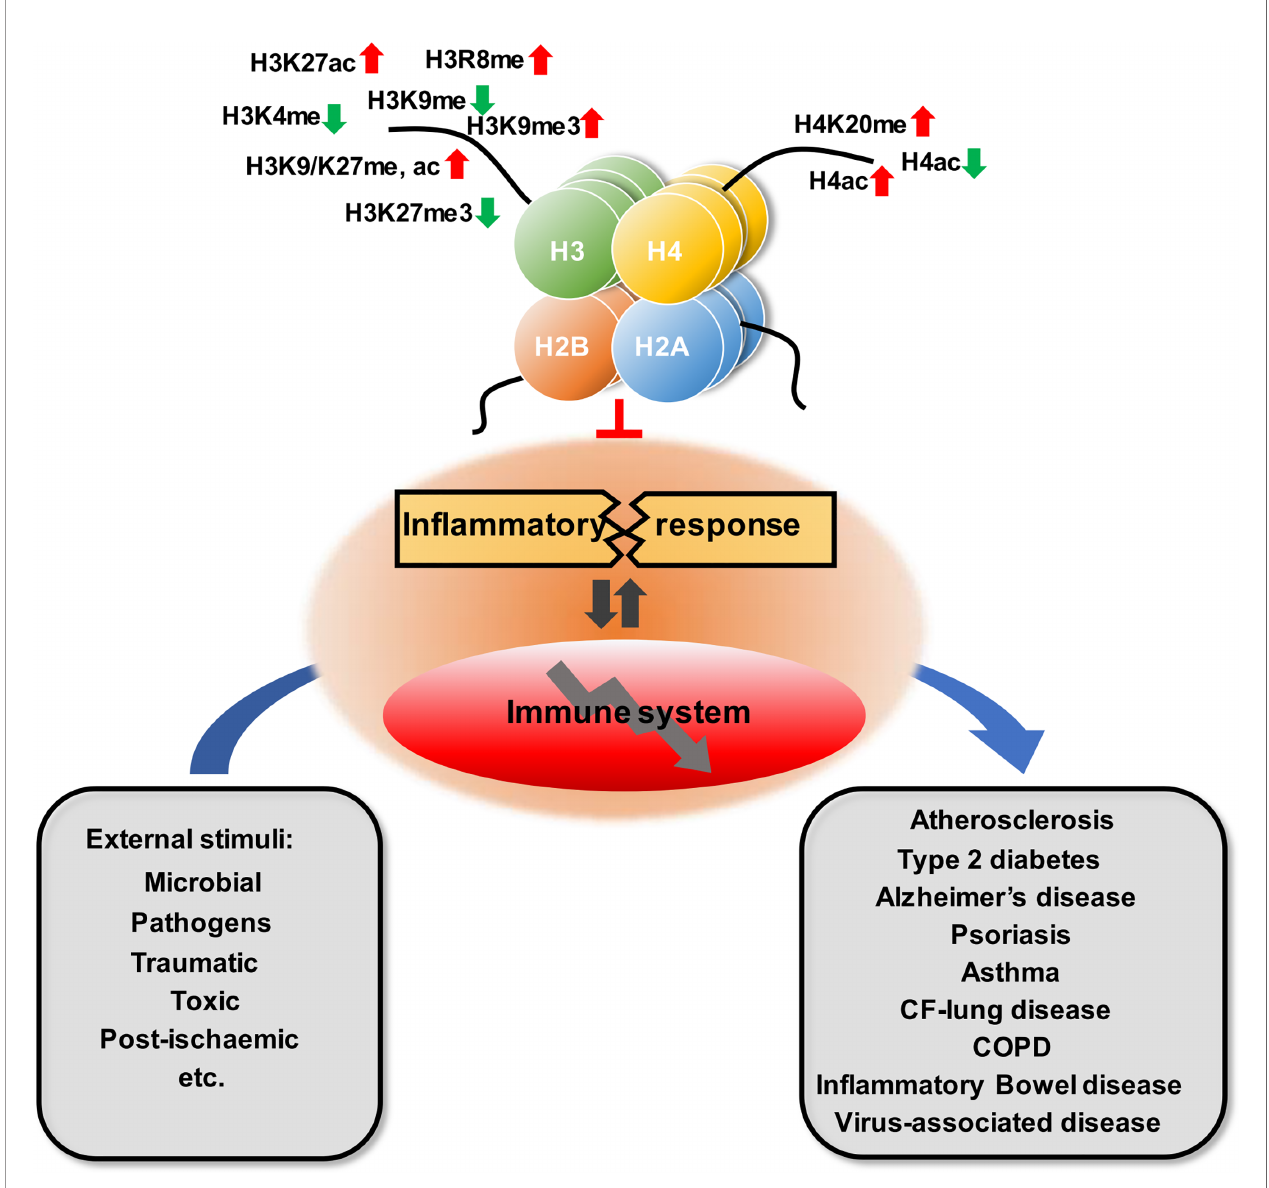
FIGURE 1 | Overview of the role of histone modi fi cation in in fl ammatory